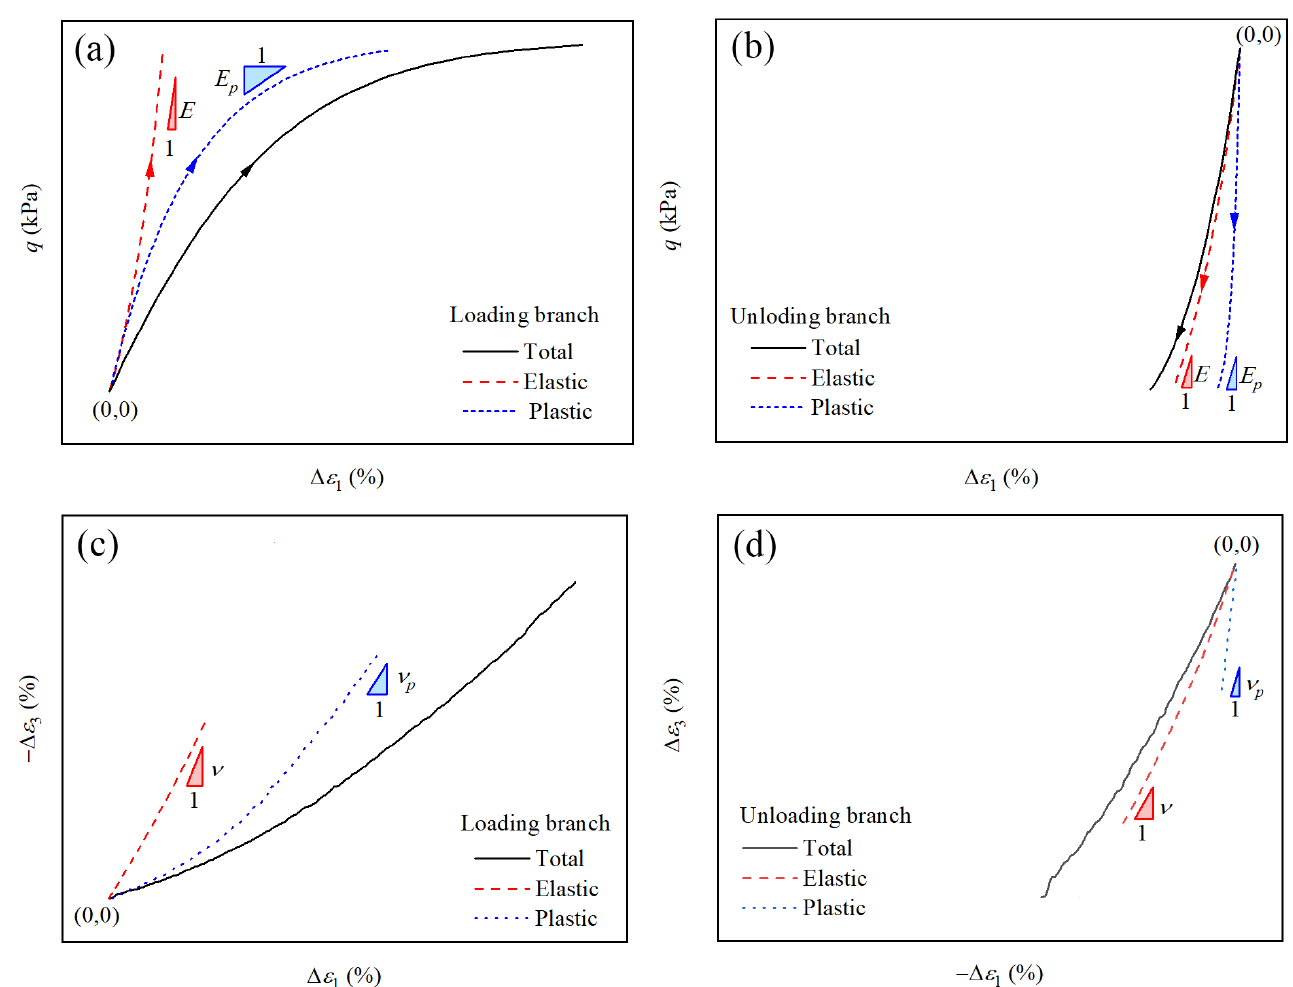
Figure 3. Elastic and plastic branches in ( a ) reloading stress–strain curves, ( b ) unloading stress–strain curves, ( c) reloading radial–axial strain curves, and ( d ) unloading radial–axial strain curves .